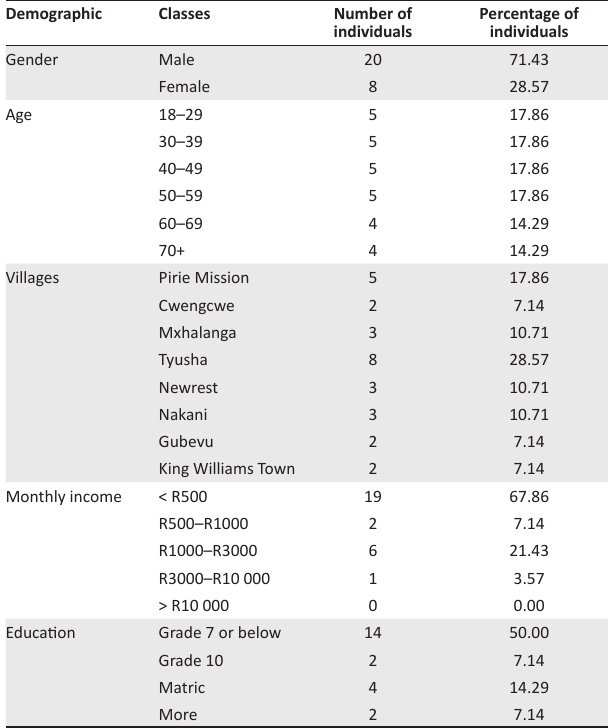
TABLE 1: The demographics of the participants interviewed at the Pirie forest, South Africa. Demographic